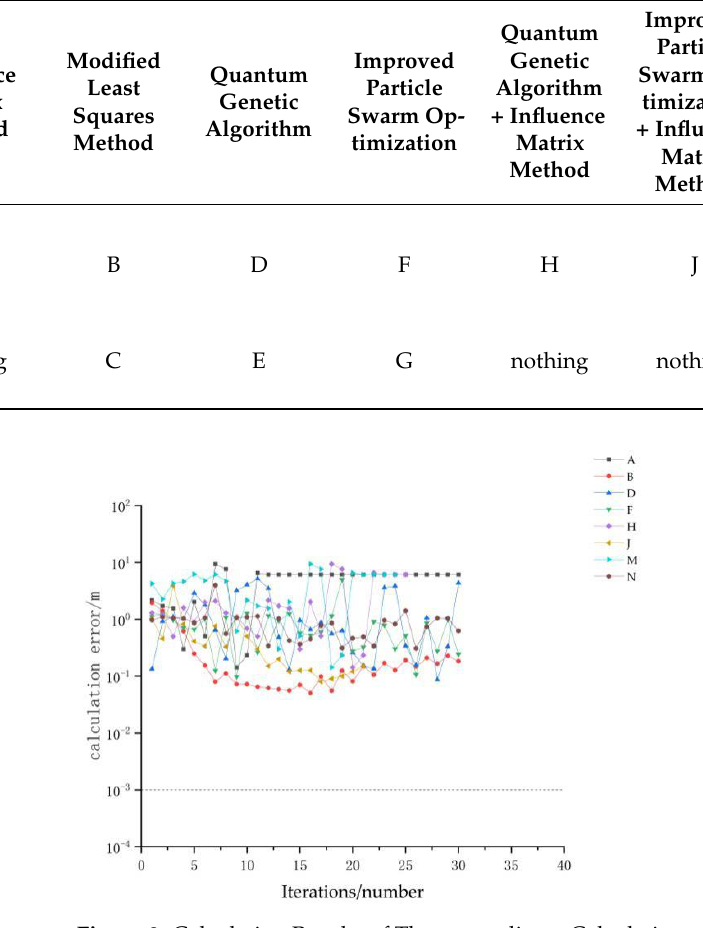
Figure 3. Calculation Results of Three-coordinate Calculation.